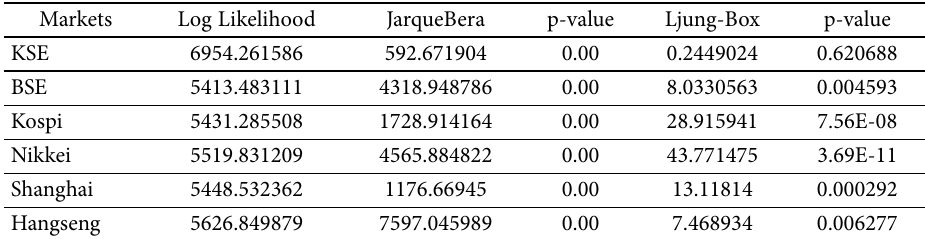
Table 7. JarqueBera&Ljung-Box